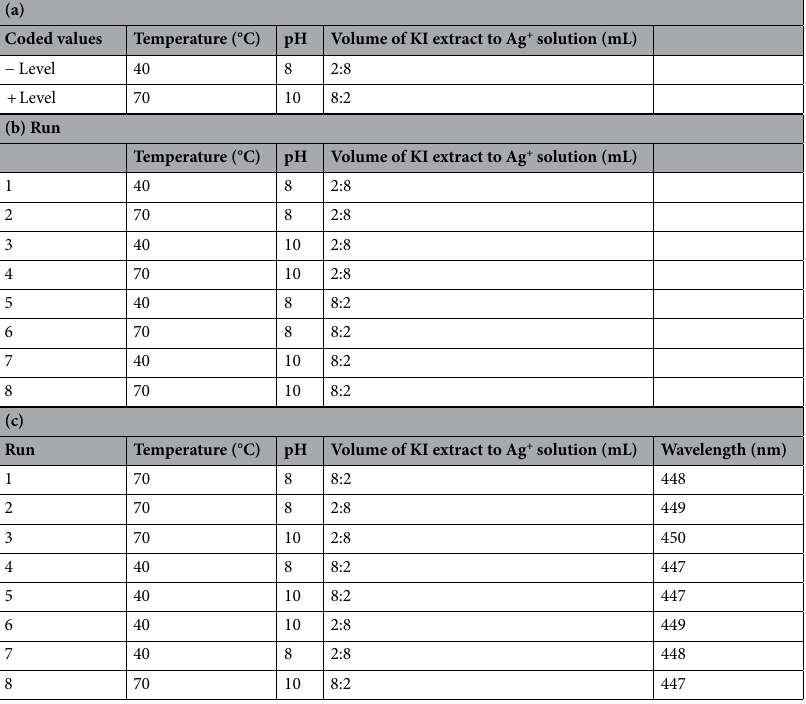
Table 2. (a) 2 3 factorial design matrix; (b) detailed experimental run for green synthesis of KIAgNPs and (c) wavelength response of green synthesized